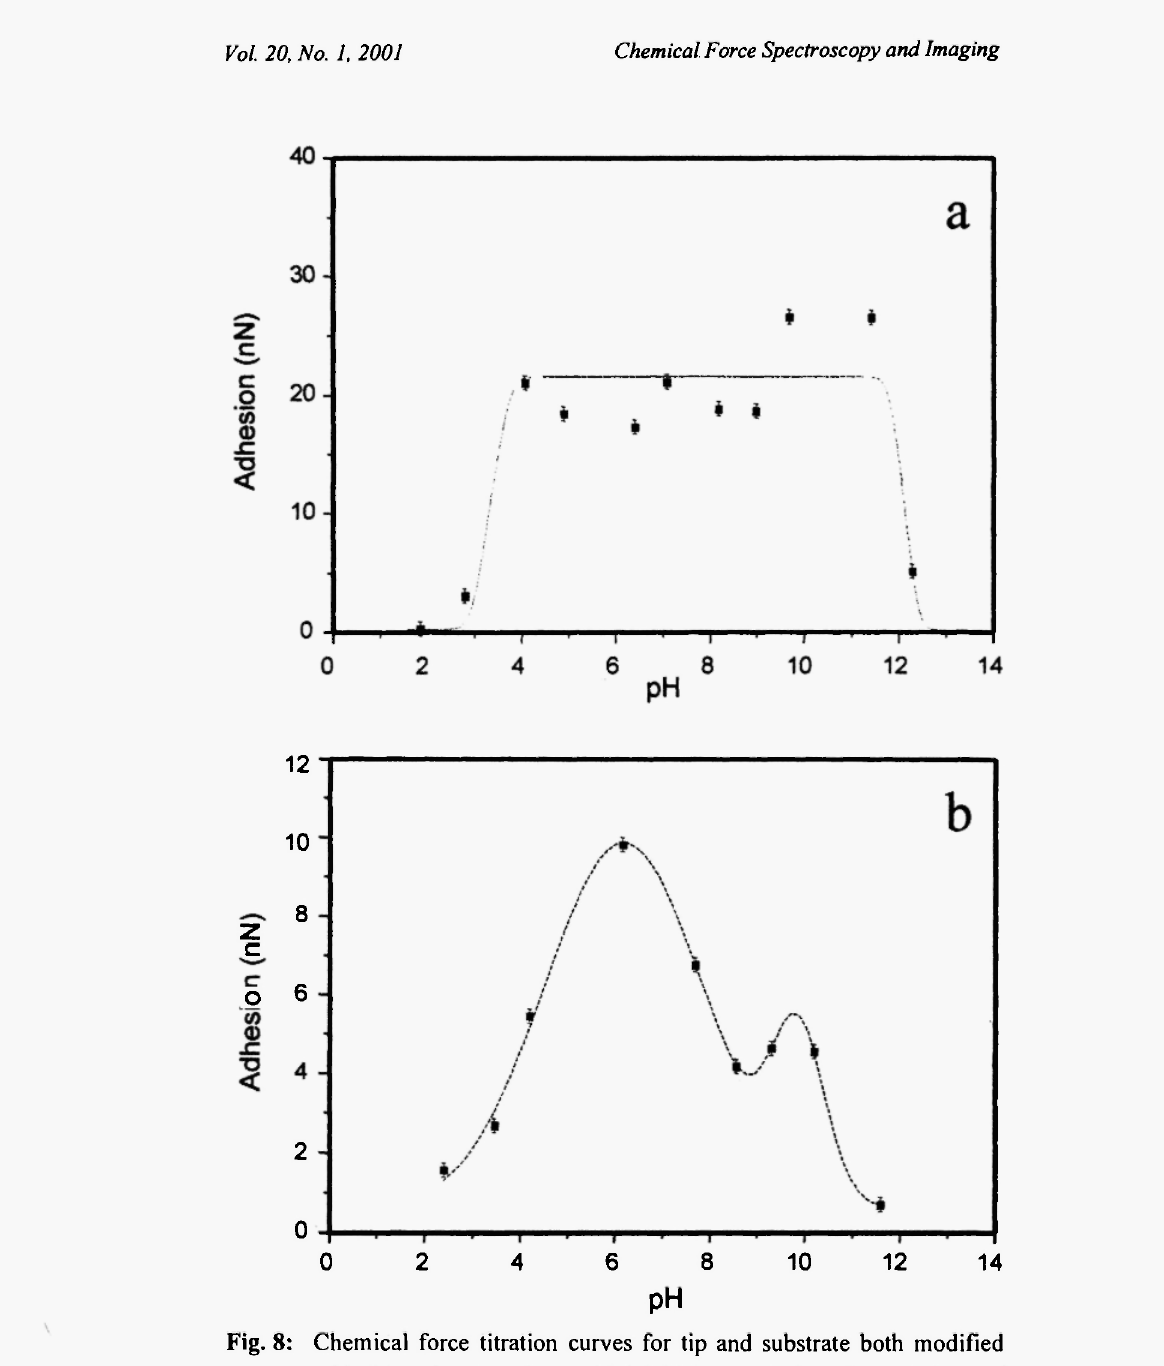
Fig. 8: Chemical force titration curves for tip and substrate both modified with 11 -amino-1-undecanethiol SAMs acquired under solutions of two ionic strengths : (a) 10"' Μ and (b) 10" 4 M. (The curves have been added as a guide to the